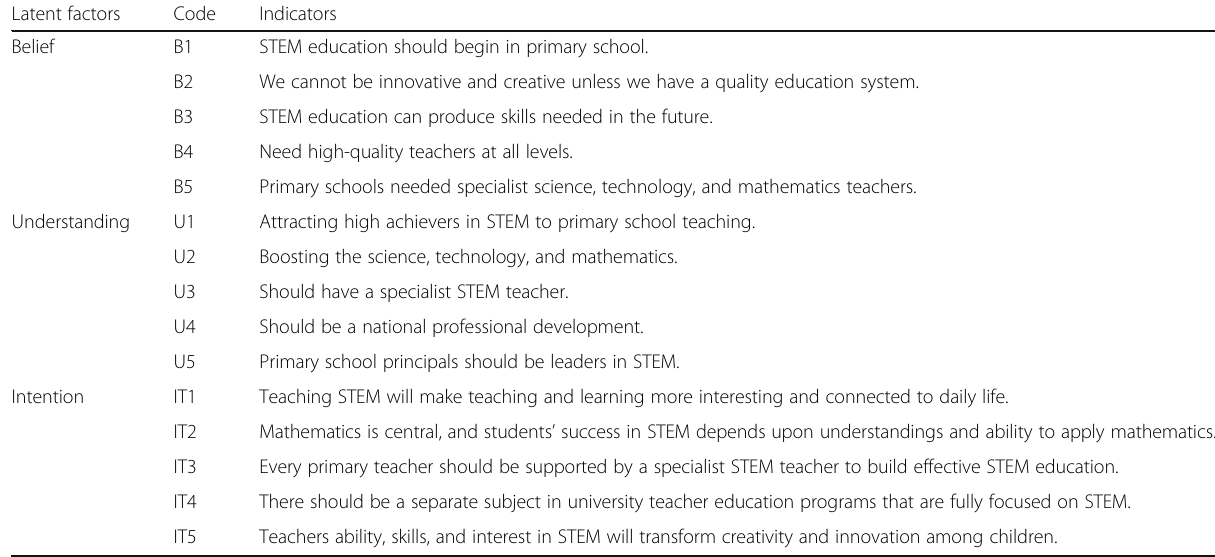
Table 3 Latent factors and their indicators of beliefs, understandings, and intentions Latent